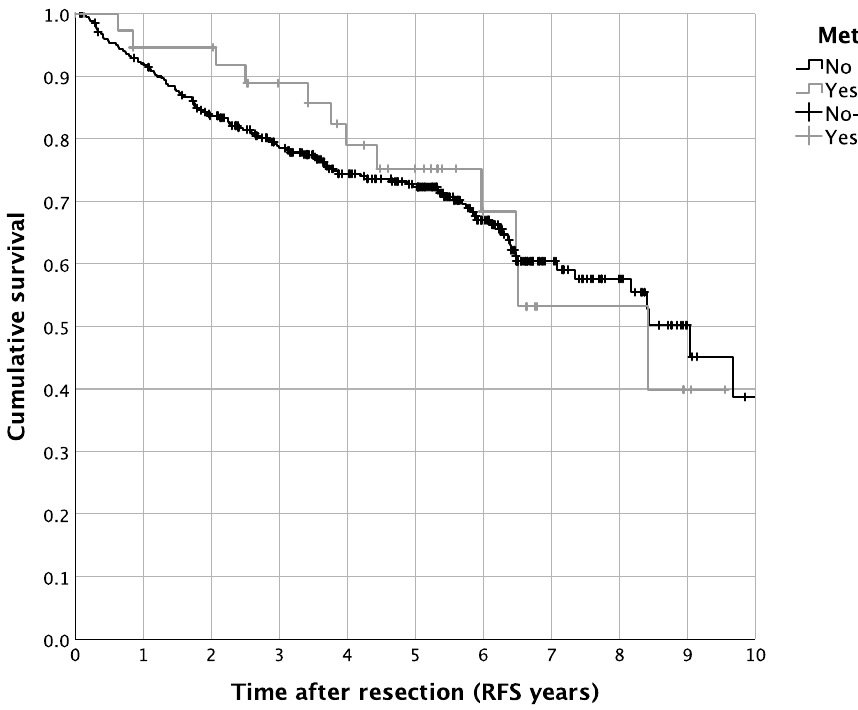
Figure 1. Survival of HNM patients differentiated by metformin use: Kaplan–Meier curves for RFS ( p = 0.806, n = 382, patients with routine metformin medication: n = 39). Table 1. Patients clinico-pathological characteristics according to a diagnosis of diabetes ( n = 382).